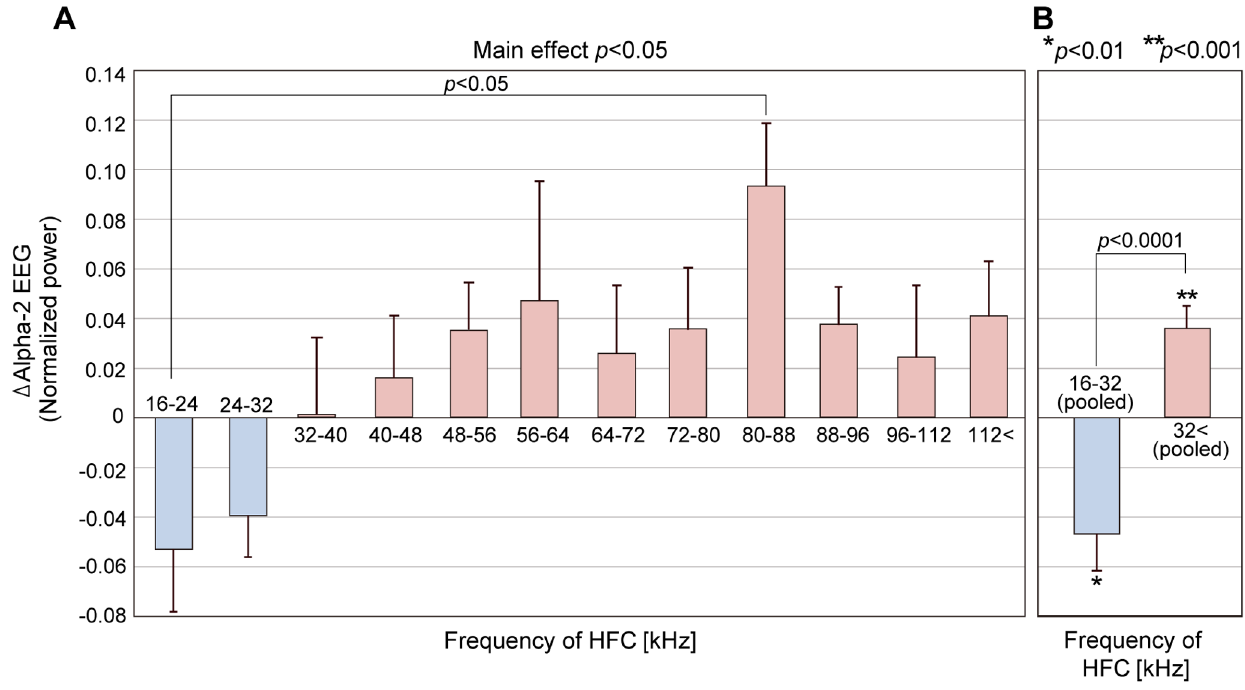
Figure 5. Results of Experiment 2: detailed examinations of frequency dependency of the hypersonic effect. A: Mean ( + SE) values of D Alpha-2 EEG across the subjects in each of twelve sub-experiments. The frequencies indicate the frequency range of HFC that were applied together with LFC ([LFC + HFC]) in comparison with the control ([LFC] alone). D Alpha-2 EEG is calculated by subtracting Alpha-2 EEG obtained during [LFC] from those during [LFC + HFC] in each subject. Univariate ANOVA showed the main effect of the frequency of HFC ( p , 0.05). Tukey’s post-hoc tests showed a significant difference between D Alpha-2 EEG obtained with [LFC + HFC 16-24 ] and that obtained with [LFC + HFC 80–88 ] ( p , 0.05). B: Comparison of D Alpha-2 EEG between two groups of pooled data obtained in the sub-experiments using HFC below 32 kHz and those obtained in the sub- experiments using HFC above 32 kHz. Unpaired t-tests showed significant difference between the two groups and 1-sampled t-tests showed significant difference from zero for each group, that is, D Alpha-2 EEG obtained by using HFC below 32 kHz was significantly negative ( p , 0.01), while those obtained by using HFC above 32 kHz was significantly positive ( p , 0.001).